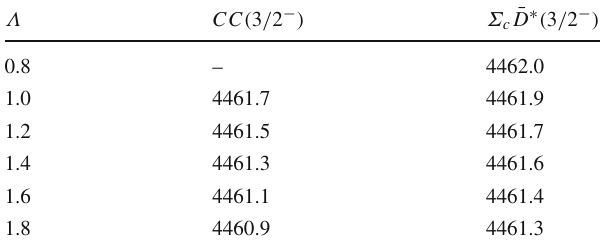
Table 3 The position of the bound states with J P = 3 / 2 − in a unit of MeV. The Λ in the unit of GeV is the cutoff in the exponential regularization. The CC means coupled-channel calculation and Σ c ¯ D ∗ means the single-channel calculation of Σ c ¯ D ∗